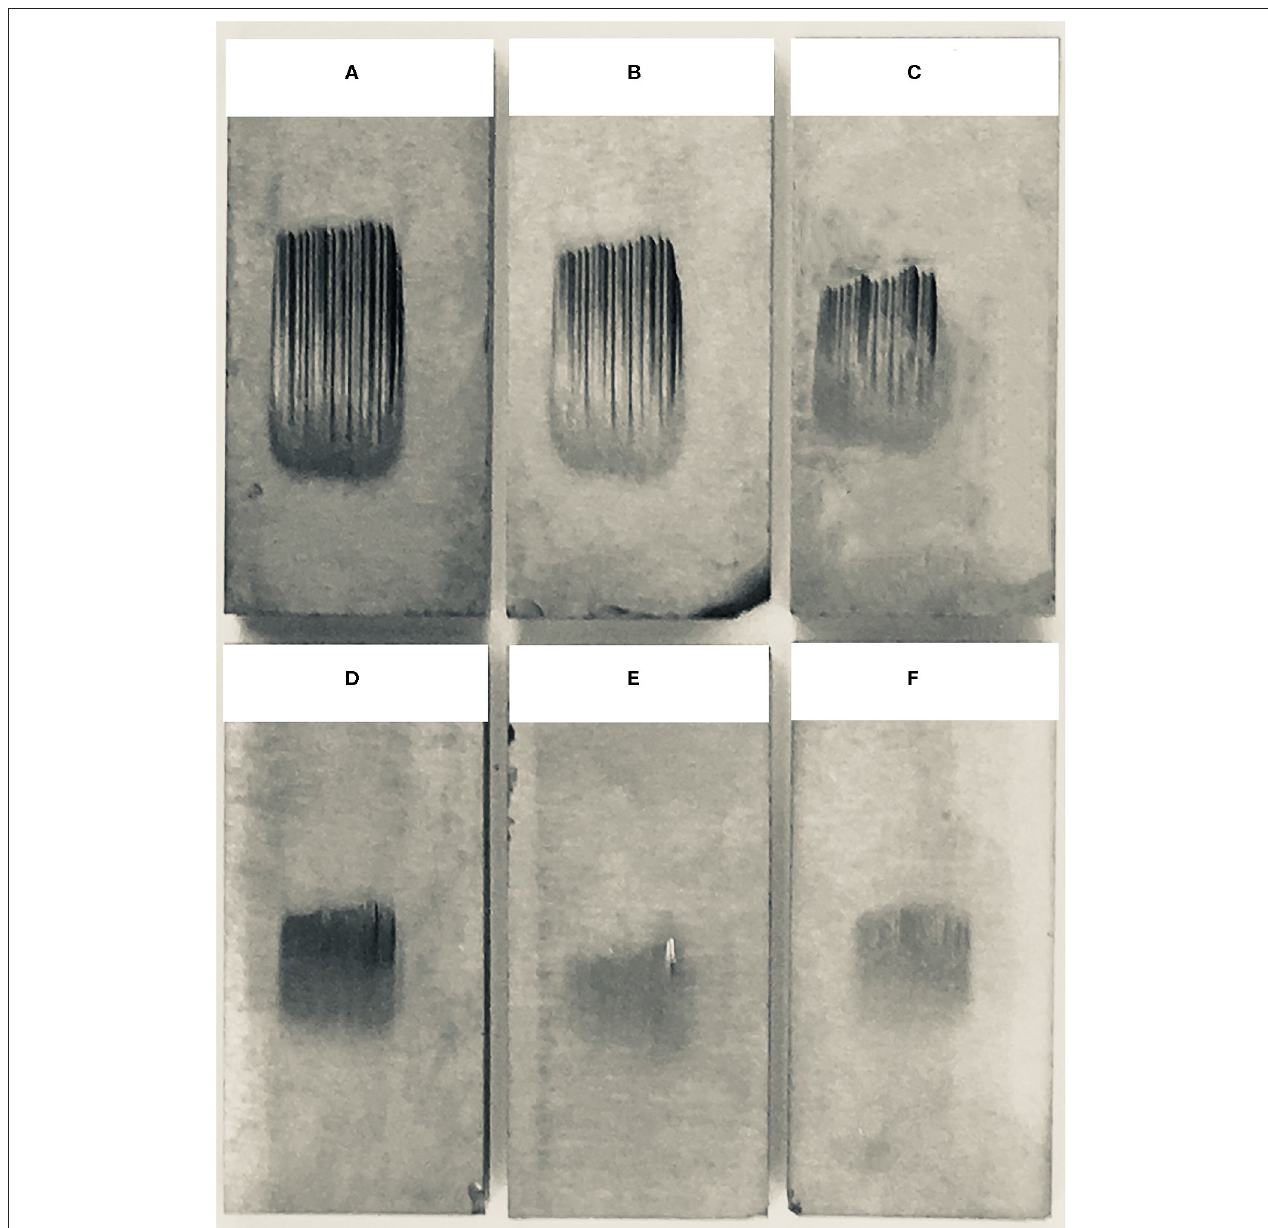
FIGURE 6 | Photos of the alloys with different Mo 2 C addition amount after abrasive wear testing: (A) 0% Mo 2 C; (B) 1.2% Mo 2 C; (C) 2.4% Mo 2 C; (D) 3.6% Mo 2 C; (E) 4.8% Mo 2 C; (F) 6.0% Mo 2